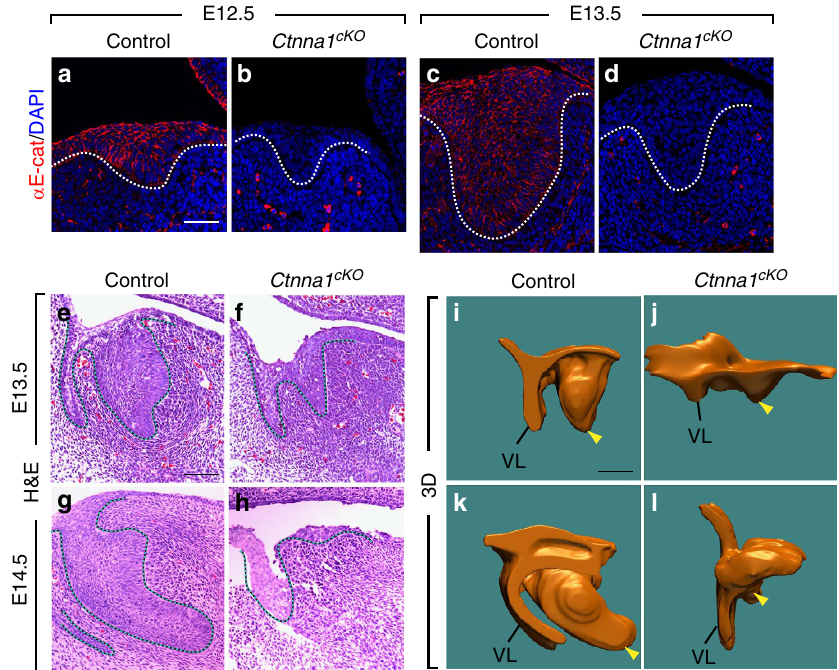
Figure 4 | a E-catenin is required for incisor epithelium invagination. ( a – d ) a E-catenin is normally expressed throughout the dental epithelium at E12.5 and E13.5, but expression is absent in Ctnna1 cKO . ( e – l ) Histological analysis and 3D reconstruction show smaller and abnormally shaped tooth germs at E13.5 and developmentally arrested epithelia at E14.5 in Ctnna1 cKO ( f , h , j , l ) when compared with littermate controls ( e , g , i , k ). Dotted lines outline the tooth germ epithelium in a – h , and yellow arrowheads indicate the tooth germ epithelium in i – l . VL, vestibular lamina. Scale bar, 25 m m ( a – d ); 100 m m ( e – h ); 200 m m ( i – l